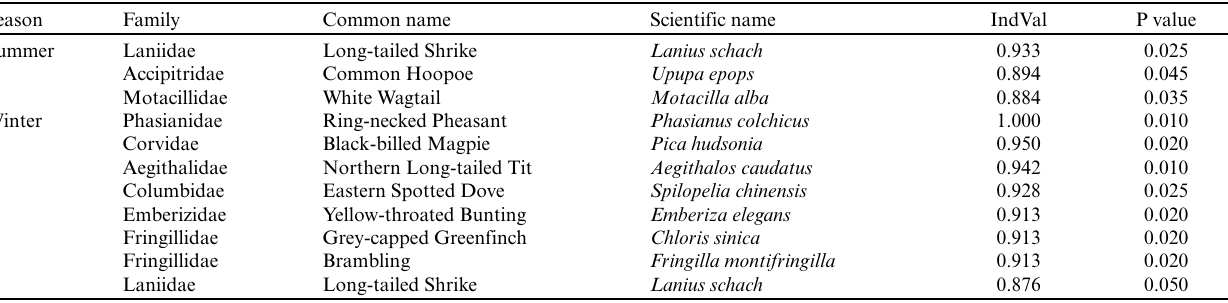
Table 3 . Results of indicator species analysis (De Cáceres and Legendre 2009), showing that three species in summer and eight in winter were significantly associated to abandoned villages in the Huaibei coal mining area in the North China Plain. The indicator value (IndVal) represents the degree to which a given species is associated with the habitats. No significant associations were found in inhabited villages in either